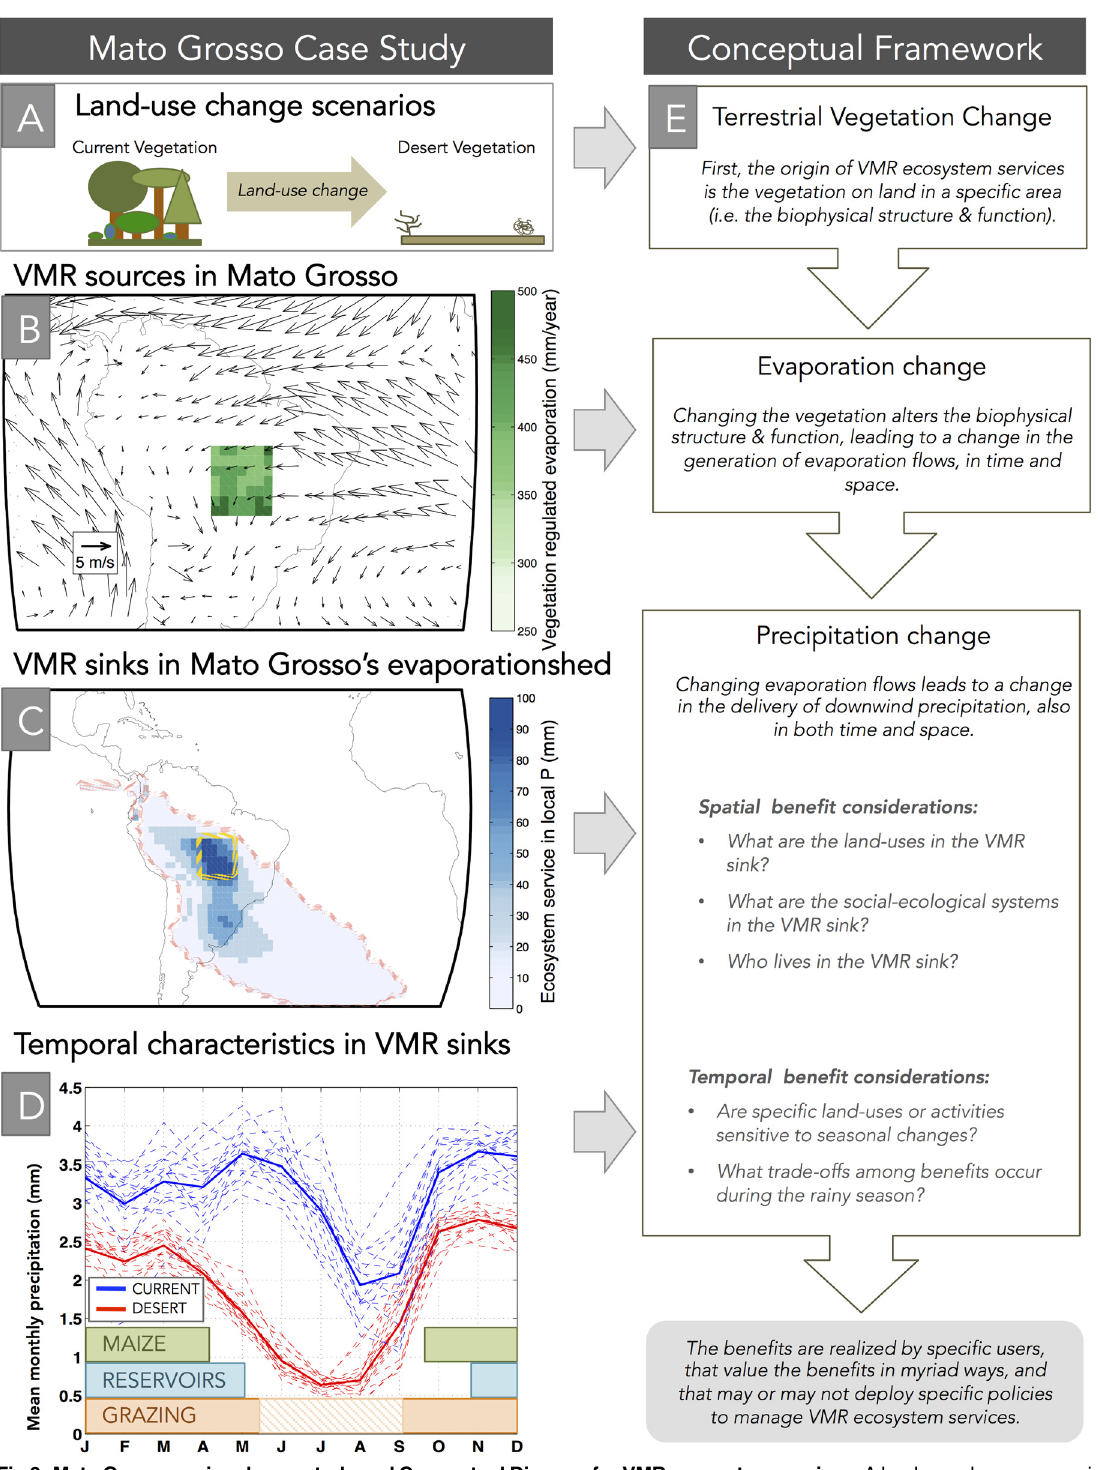
Fig 3. Mato Grosso regional case study and Conceptual Diagram for VMR ecosystem services. A land-use change scenario that replaces current vegetation with desert land (a), is used to derive the amount of vegetation-regulated evaporation (i.e. VMR sources) for the Mato Grosso region of Brazil (b); the arrows in panel (b) depict annual average wind directions in the lower level of the atmosphere. The region downwind of this VMR source is the VMR sink region, also known as the evaporationshed for Mato Grosso (c). The temporal dynamics of VMR precipitation (d), depicting average, monthly variation between the current (blue) and desert (red) vegetation scenarios are shown alongside the seasonal overlap of important sectors affected by precipitation including